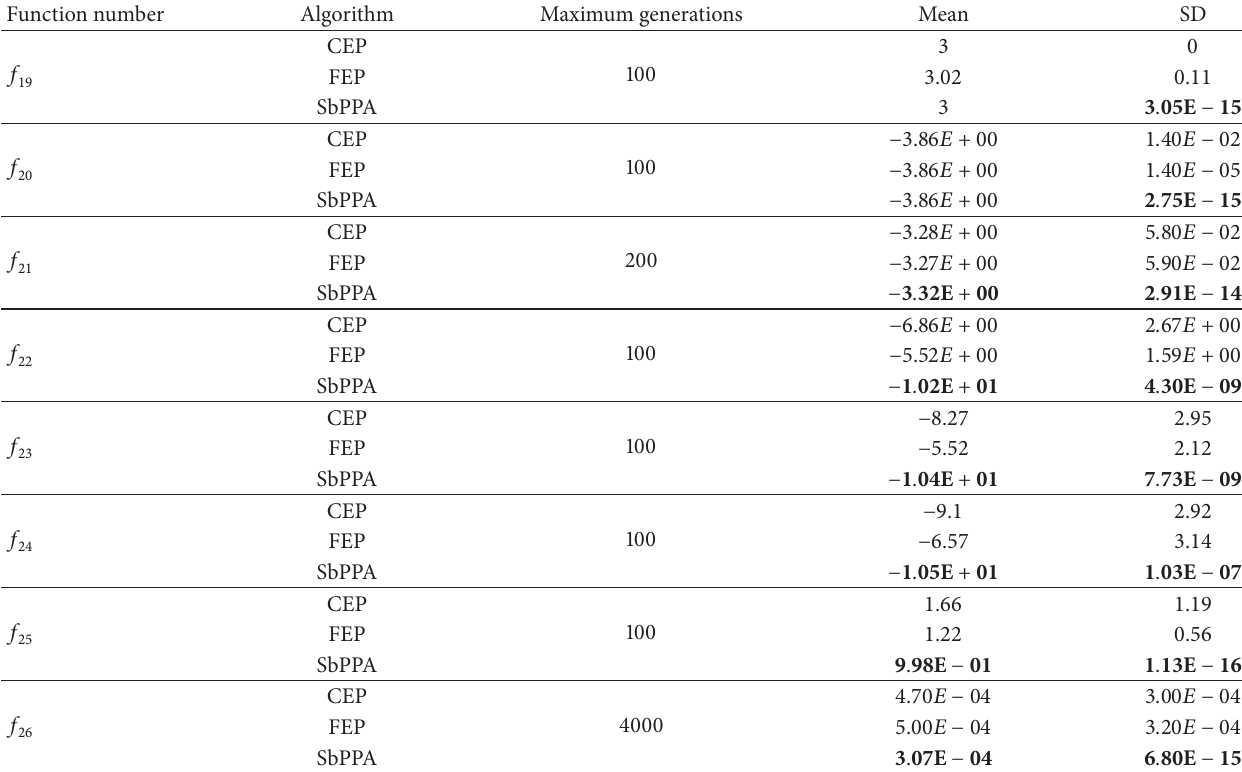
Table 6: Results obtained by SbPPA, CEP, and FEP. All problems in this table are unconstrained [30]. Function